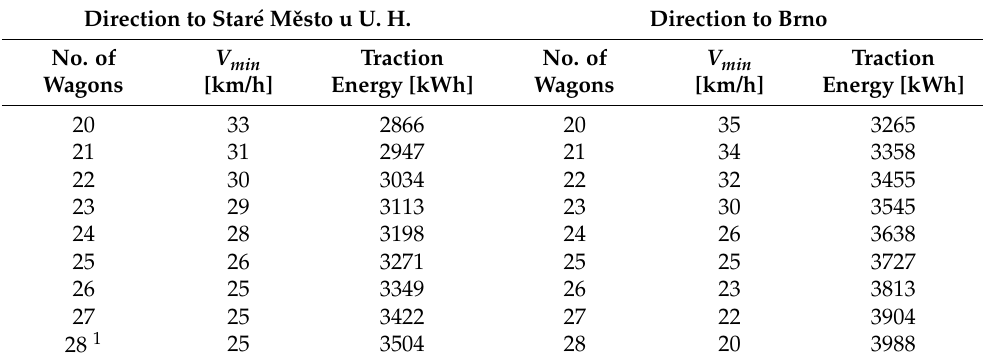
Table 12. Sensitivity analysis for the model train with Stadler locomotive on the line